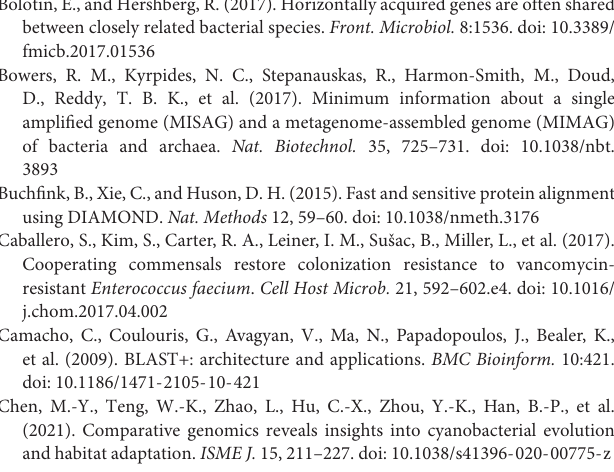
Supplementary Figure 7 | Pie Chart representations for the COG meta-categories found in the gained and missed gene families at different LCAs from different lineages of the Blautia evolution, observed in the set of representative genomes (see Figure 4 ). Gene families were annotated using COG.